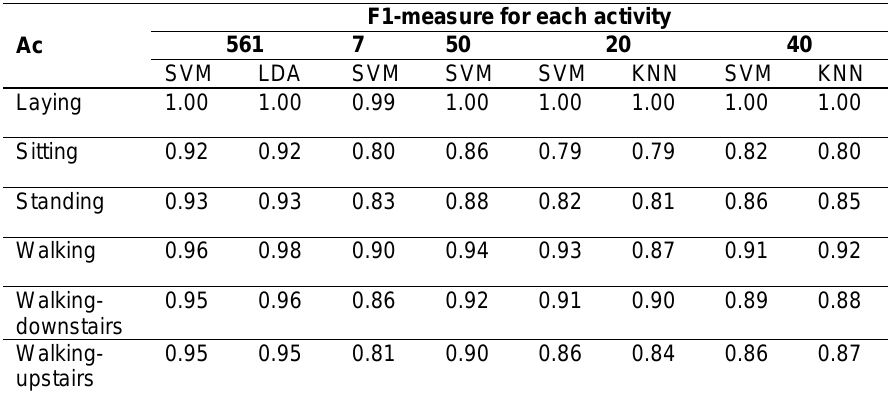
TABLE 3: Comparative results: F1-measure for each